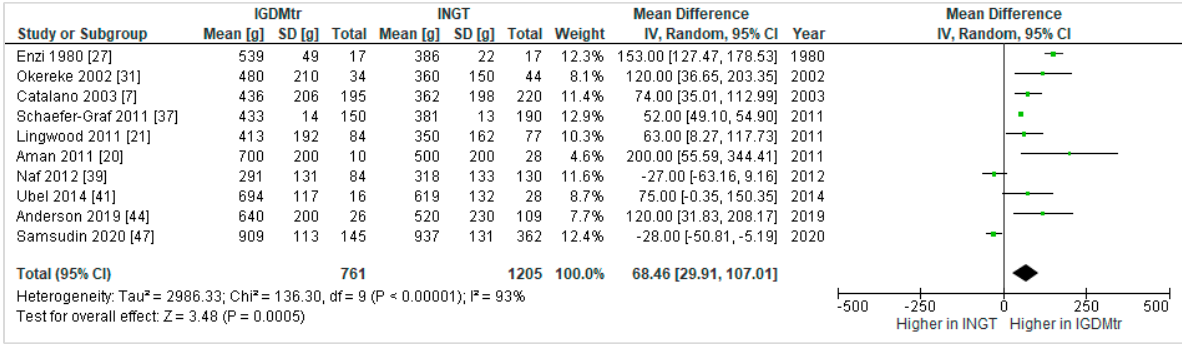
Figure 2. Forest plot comparing fat mass (g) in infants exposed to treated gestational diabetes mellitus (IGDMtr) and infants exposed to normal glucose tolerance (INGT).